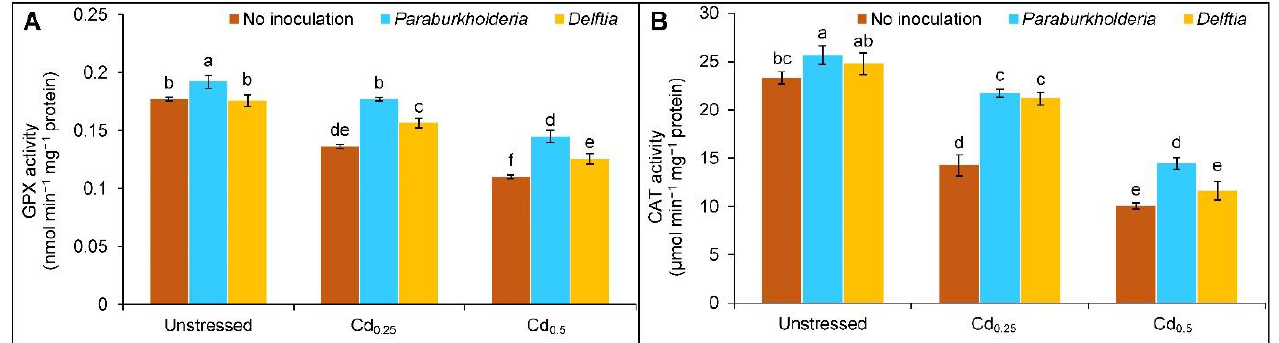
Figure 6. Effect of Paraburkholderia fungorum and Delftia sp. on the activities of ( A ) glyoxalase I (Gly I) and ( B ) glyoxalase II (Gly II) of rapeseed under different levels of CdCl 2 . Here, Cd 0.25 and Cd 0.5 indicated 0.25 and 0.5 mM CdCl 2 , respectively. Different letters on the bars indicate statistical sig- nificance at 5% levels of probabil ity following Tukey’s HSD test and the mean (±SD) values obtained from three replications. 3.6. Yield Parameters The toxicity of Cd considerably declined the yield parameters of the rapeseed plants. The number of siliqua plant −1 was decreased by 28 and 73% at Cd 0.25 and Cd 0.5 , respectively, compared to the controls. However, the P. fungorum only increased the number of siliqua plant −1 in the Cd 0.5 treated plants by 55% compared to the corresponding uninoculated Cd stressed only. The siliqua length declined at Cd 0.5 by 48% compared to the controls. How- ever, the P. fungorum increased the siliqua length by 40% at Cd 0.5 stress compared to the respective Cd treated alone. Similarly, the number of seeds siliqua −1 (35 and 53%), 1000- seed weight (19 and 77%), and seed yield plant −1 (32 and 89%) were declined when treated